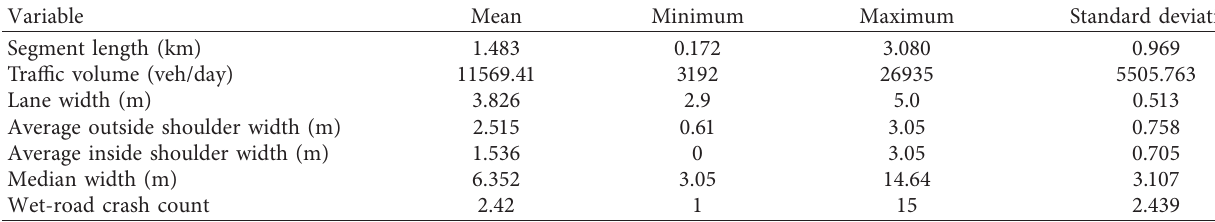
Table 1: Descriptive statistics of data (sample size: 395).